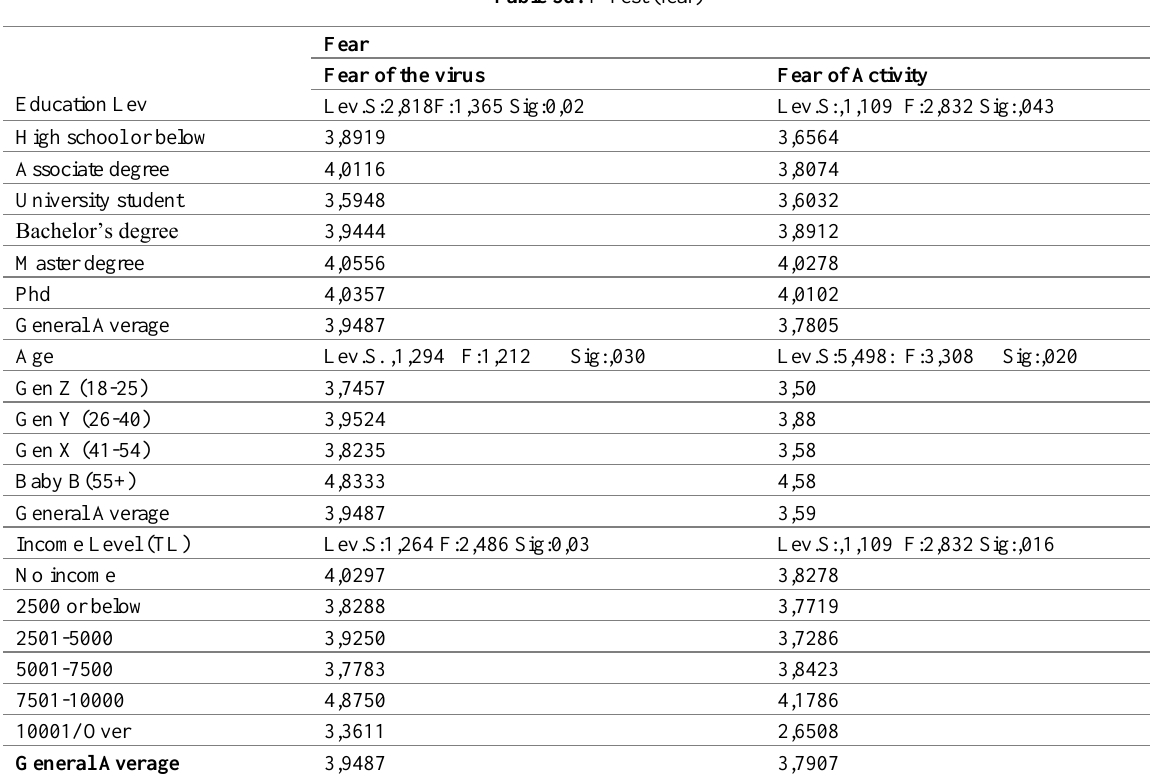
Table 5d: F Test